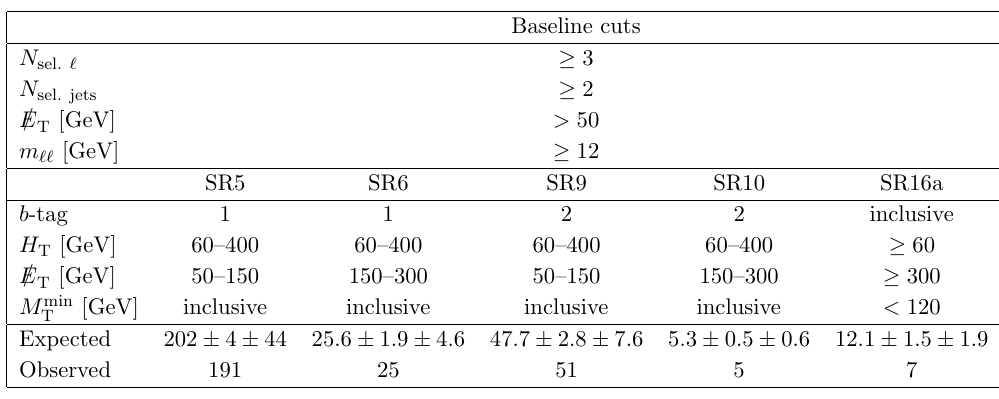
Table 7 . Summary of baseline selection cuts and selection cuts for the o(cid:11)- Z signal regions (SR) that are most sensitive to ( et )( et ) or ( (cid:22)t )( (cid:22)t ) [64]. We also list the observed and expected number of events for each SR. See text for more